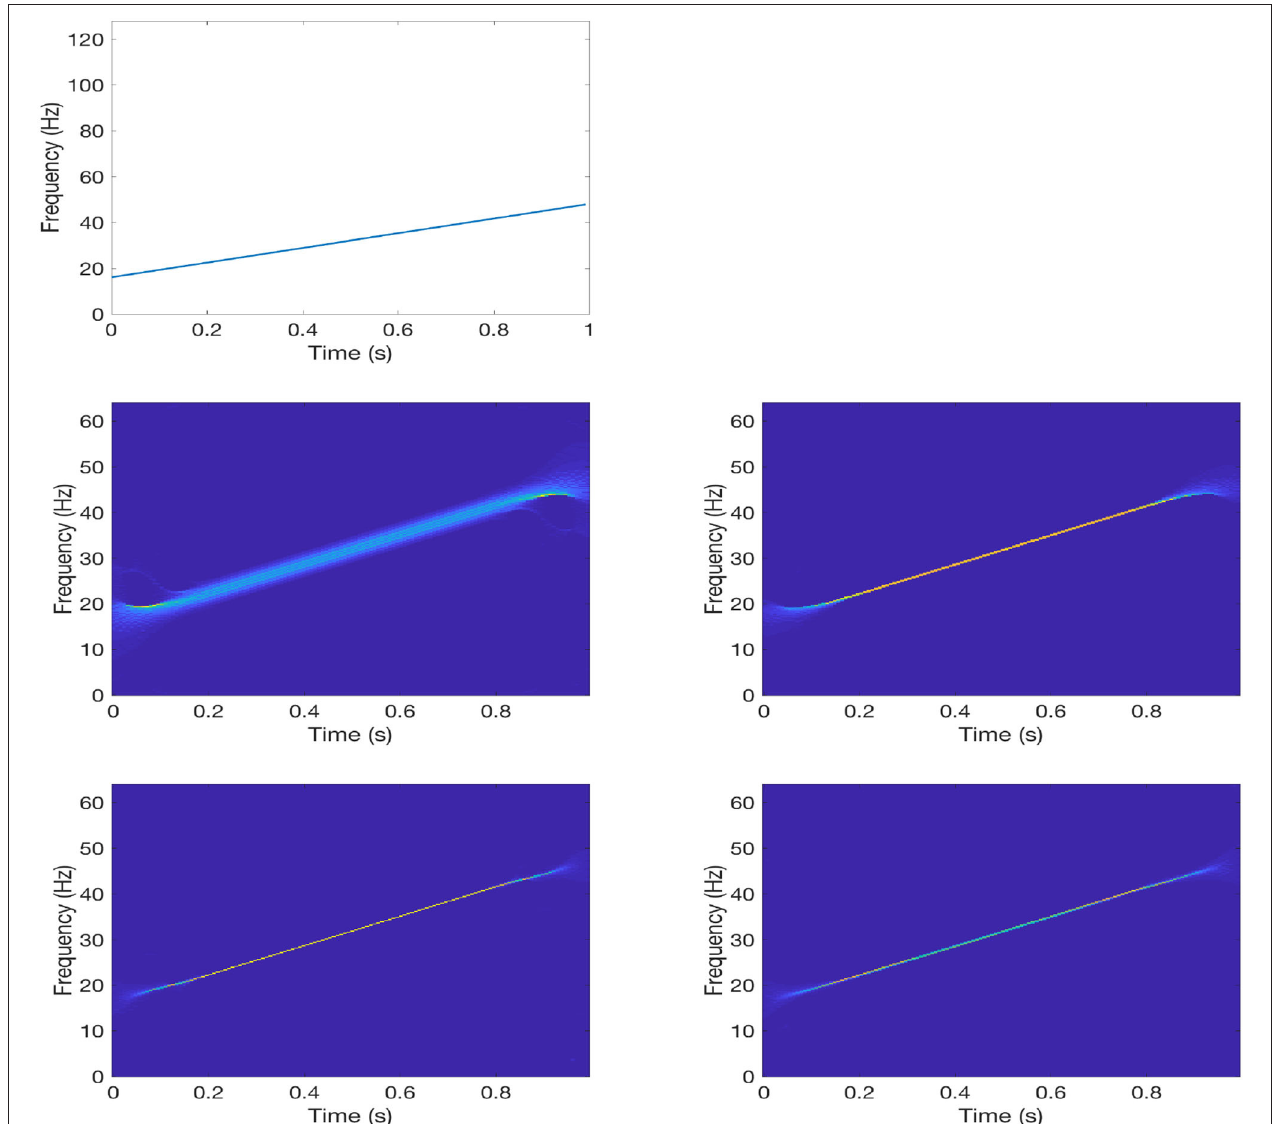
R x ( t , η ) (left) and IFE-FSST | |